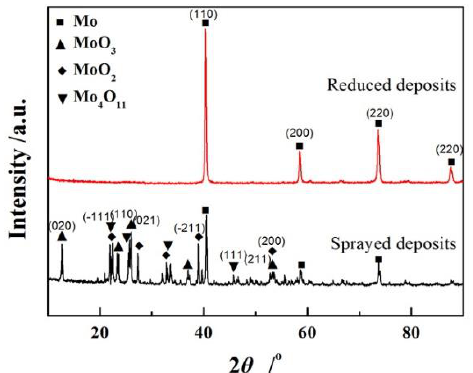
Figure 3. X-ray diffraction (XRD) diffraction patterns of sprayed and reduced porous Mo.